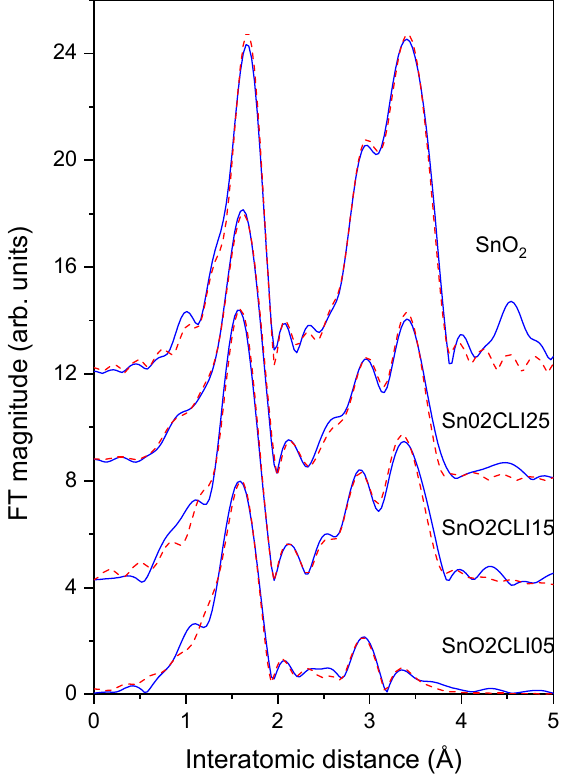
Figure 6. Fourier transform magnitudes of the k3-weighted Sn EXAFS spectra of Sn-modified CLI zeolites and reference SnO 2 compound with a rutile crystal structure, calculated in the R range of 1.2–4.0 Å and in the k range of 4.5–14.5 Å-1 (black solid line—experiment, red dashed line—EXAFS model).